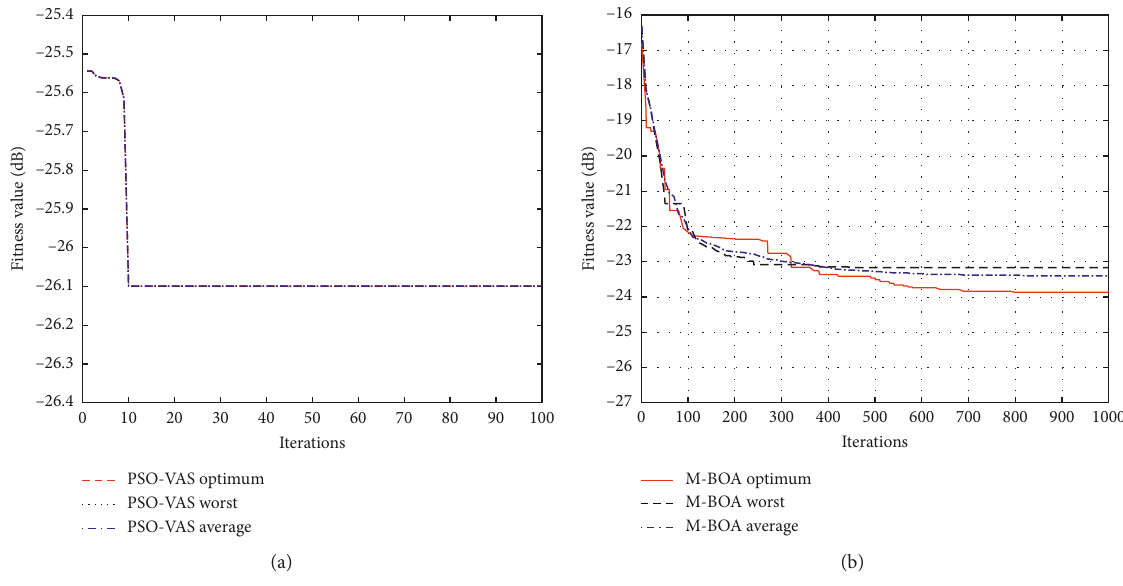
Figure 9: Fitness curve of PSO-VAS and M-BOA. (a) Fitness of PSO-VAS. (b) Fitness of M-BOA. Table 2: Comparison between the time modulation array and modified Bayesian array.